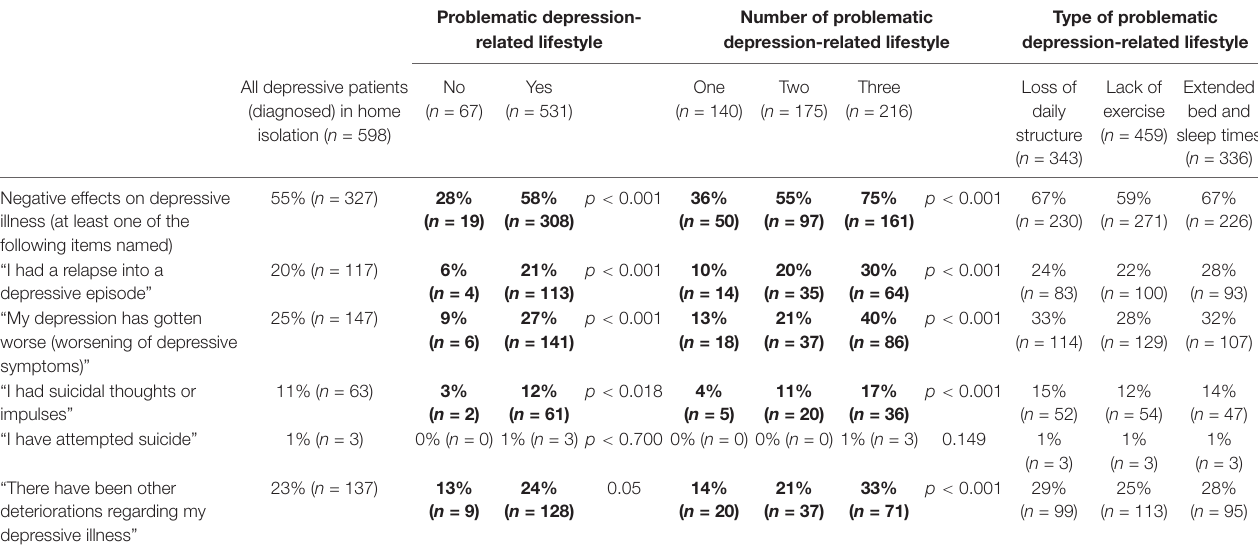
TABLE 2 | Associations of problematic depression-related lifestyle changes with depressive illness. Problematic